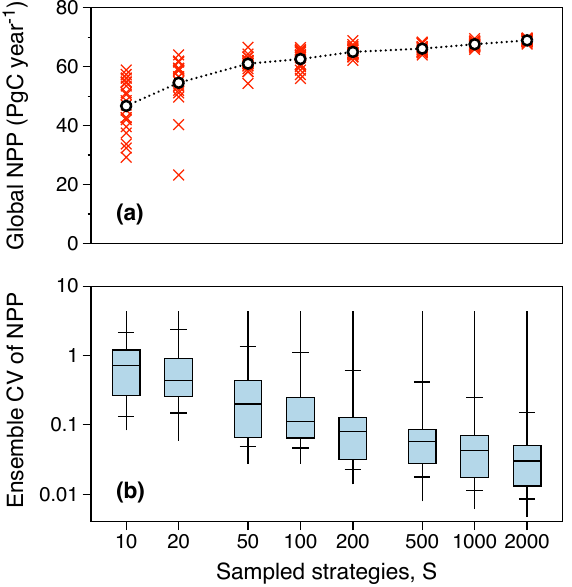
Fig. 11. (a) Scatter plot showing higher values of global terrestrial net primary productivity (NPP) and lower within-ensemble varia- tion with increasing number of sampled strategies. Each red cross represents the terrestrial NPP from a JeDi-DGVM simulation with S randomly sampled strategies. Each diversity ensemble contains 20 simulations with the same number of sampled strategies ( S = 10, 20, 50, 100, 200, 500, 1000 or 2000). The white circles represent the ensemble means. (b) Box plots showing decreasing ensemble coefficient of variation of NPP with increasing number of sampled strategies. Central boxes show the interquartile range and median across all vegetated land grid cells; vertical whiskers indicate the range; horizontal whiskers indicate the 10th and 90th